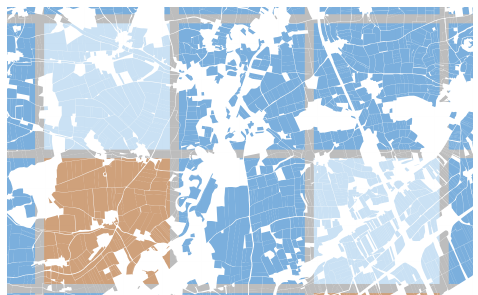
Figure 6. Illustration of the field dataset overlayed with 3km 3km blocks dedicated for training (blue), × evaluation (lightblue), and validation (orange). A circumferential margin of 200m ensures that field plots are not located in two distinct datasets. Training and evaluation datasets are randomly reassigned at each cross-validation fold .